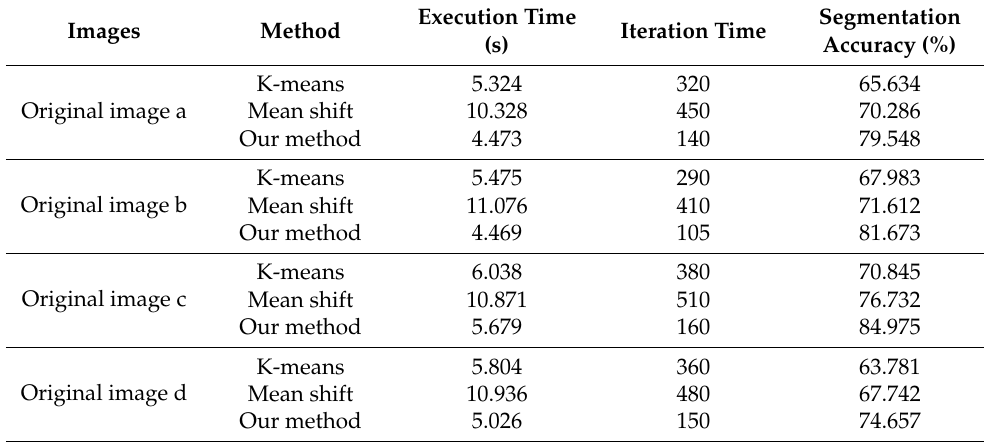
Figure 6. Iteration times of different algorithms. Table 2. Algorithm performance comparisons.